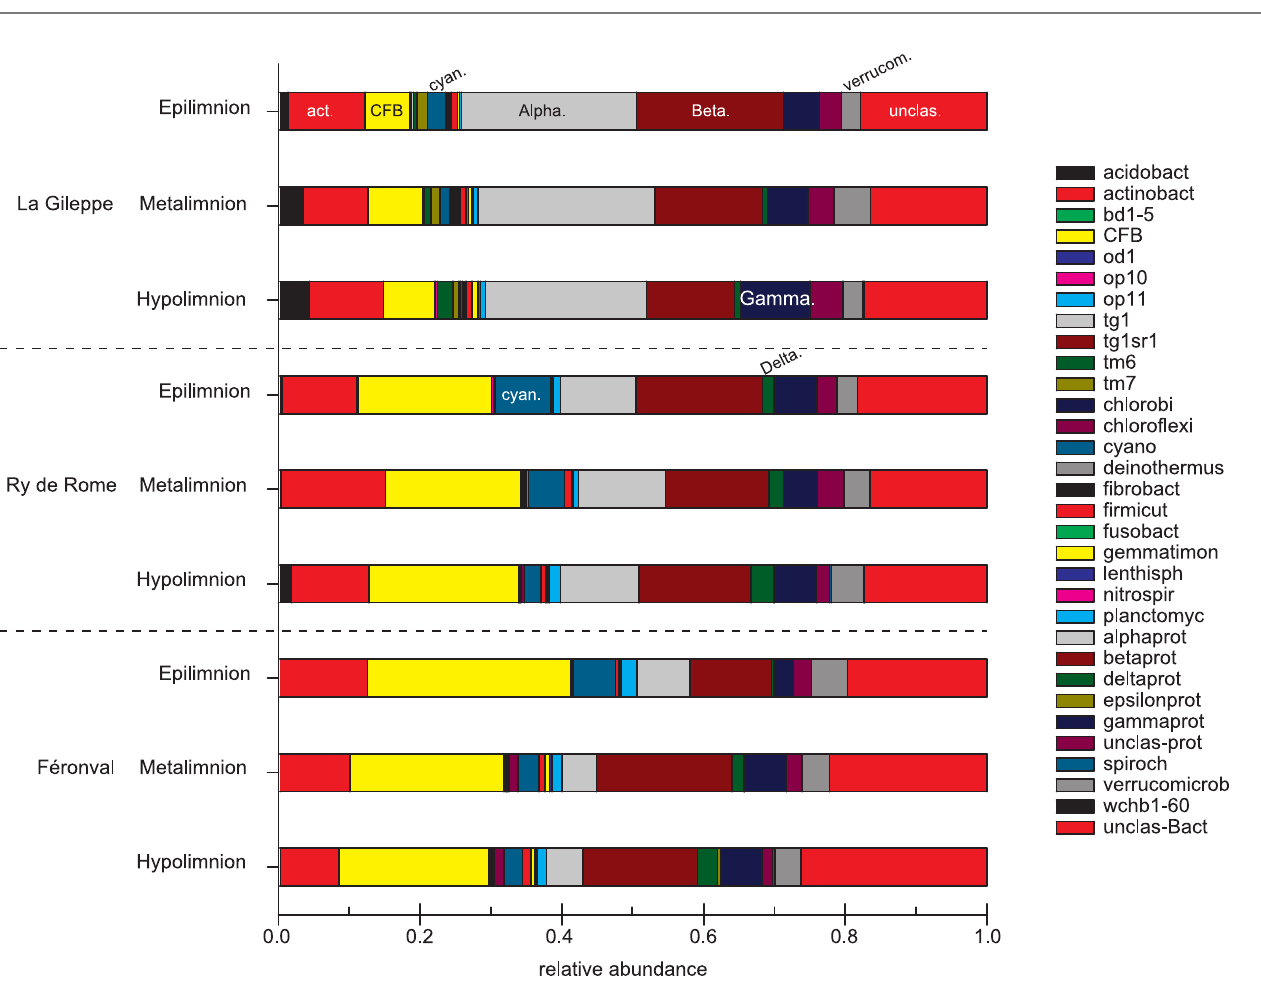
Fig. 4. Bacterial community composition. Relative proportion of bacterial retrieved groups (by b-TEFAP) at OTU level (0.03 cut-off) in the water layers of the three analysed